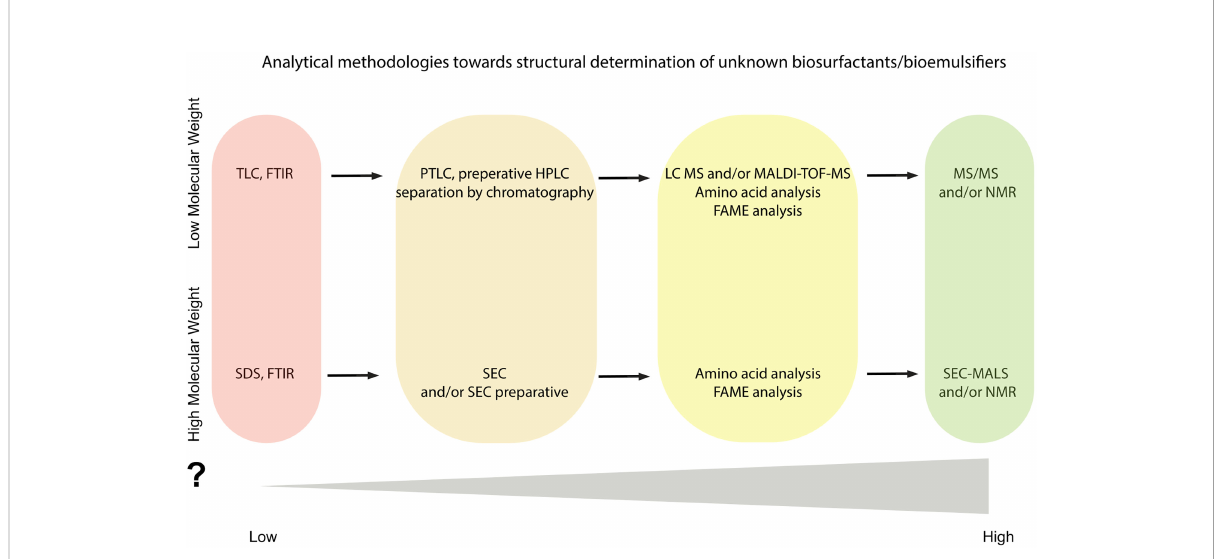
FIGURE 3 Flowchart of analytical methodologies towards structural determination of unknown biosurfactant(s)/bioemulsi fi er(s). Color gradient is indicative of the information acquired from each analytical